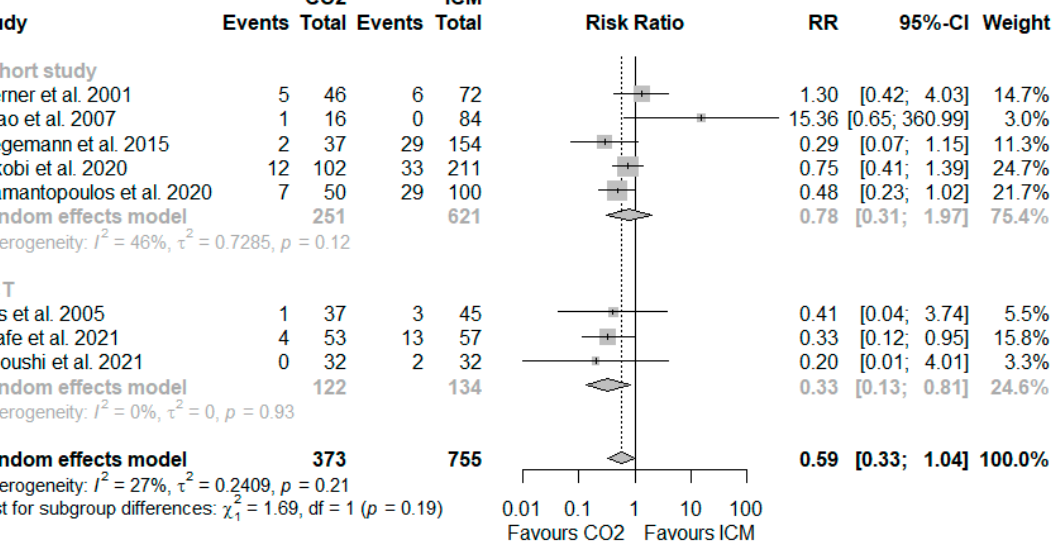
Figure 2. Forest plot for the risk of CA-AKI with CO2 compared to ICM [29–36]. Abbreviations: CA-AKI, contrast-associated acute kidney injury; CI, confidence interval; CO 2 , carbon dioxide; ICM, iodinated contrast medium; RCT, randomised controlled trial; RR, risk ratio.